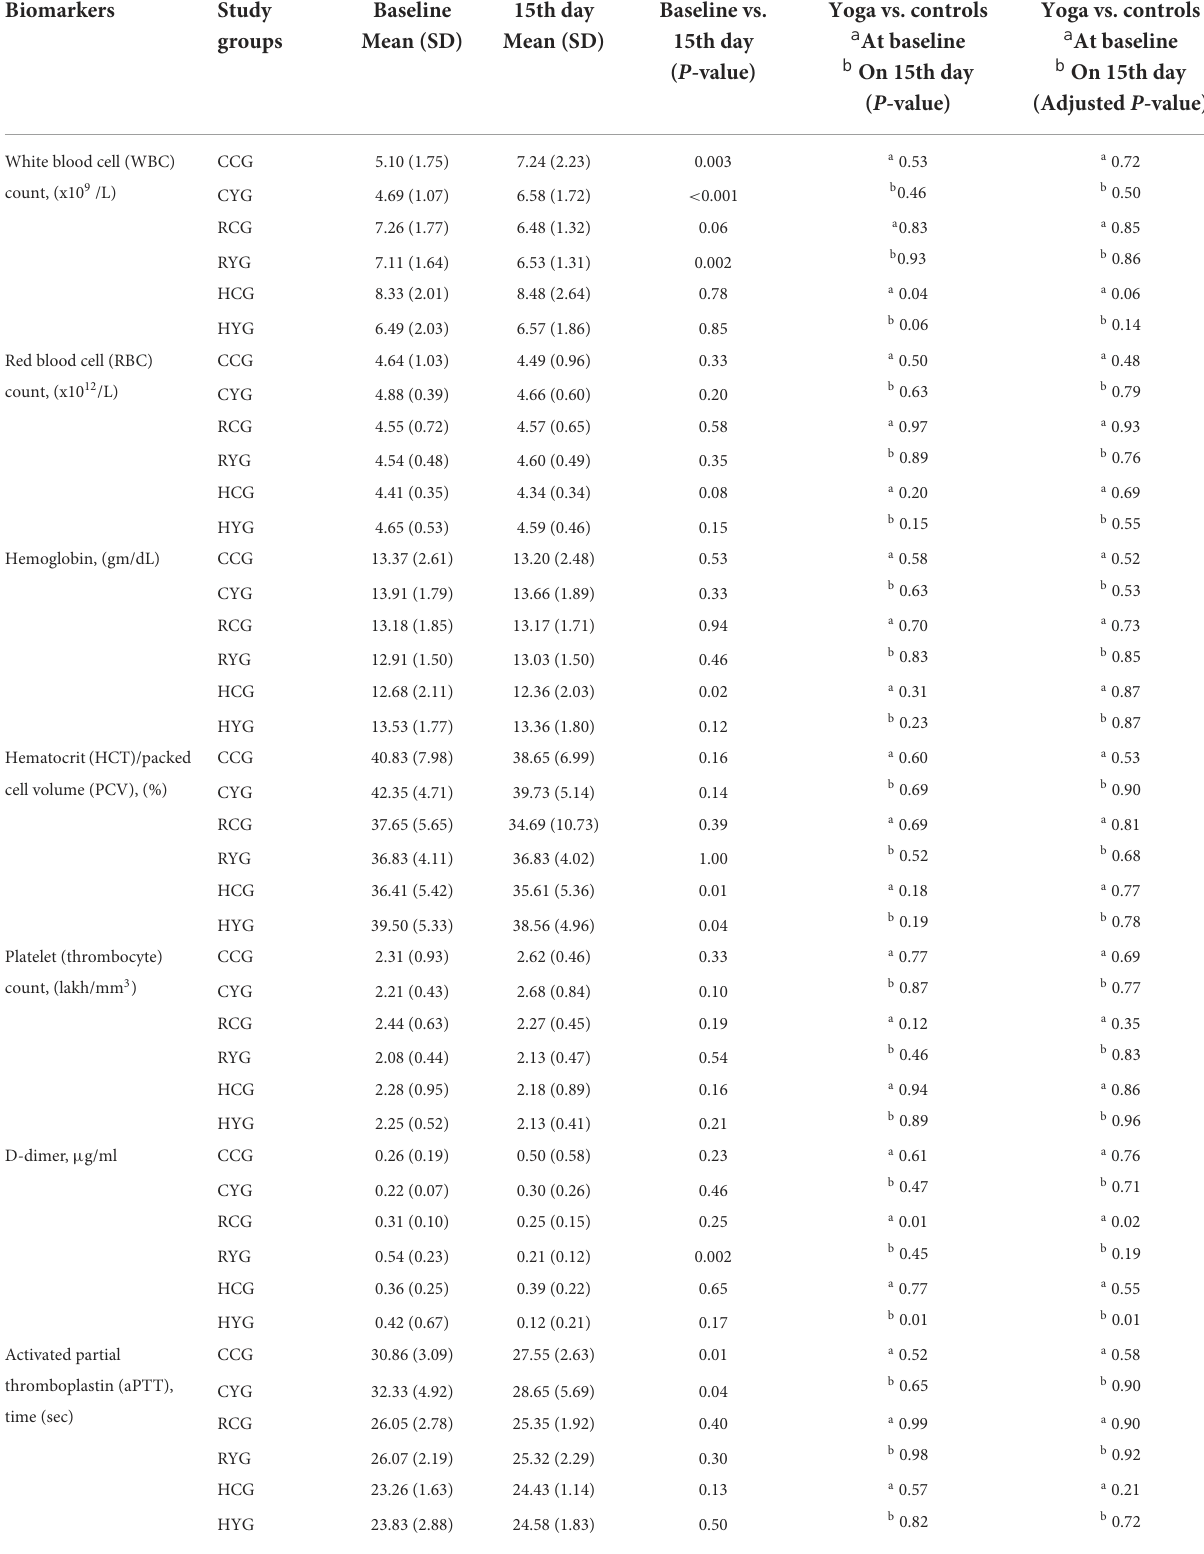
TABLE 1 Biochemical parameters in the three study groups.